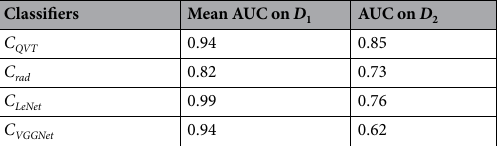
Table 2. AUC values for C QVT , C rad as well as deep learning classifiers ( C LeNet and C VGGNet ) obtained from both the training D 1 and validation D 2 cohorts.